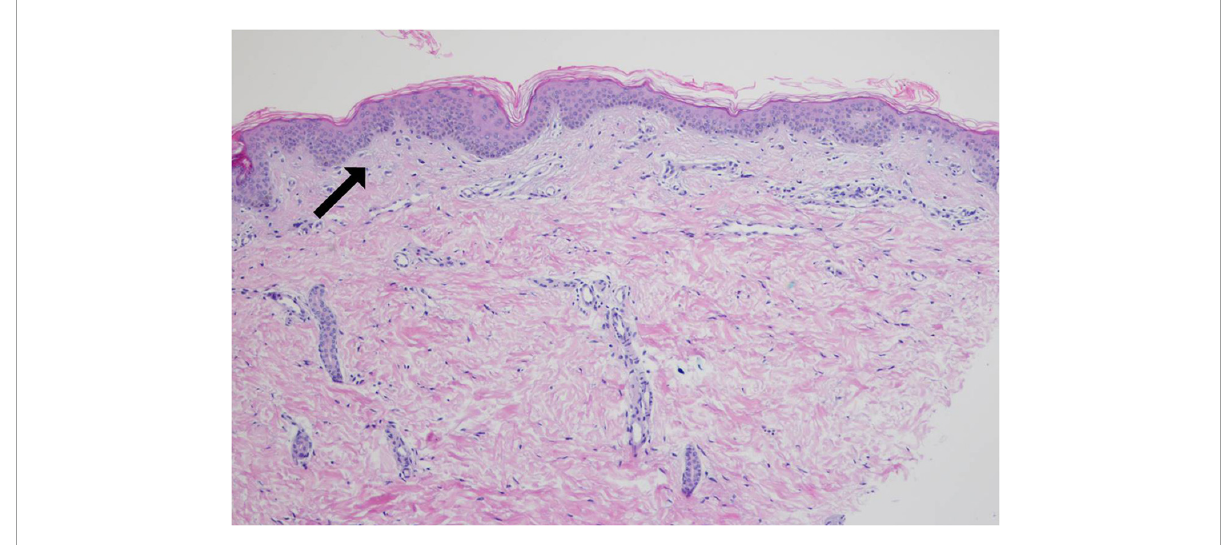
FIGURE3 Pathological biopsy result of Patient 1. The arrow indicates that there is no melanocyte in stratum basal of the depigmented area (hematoxylin-eosin staining, × 200).